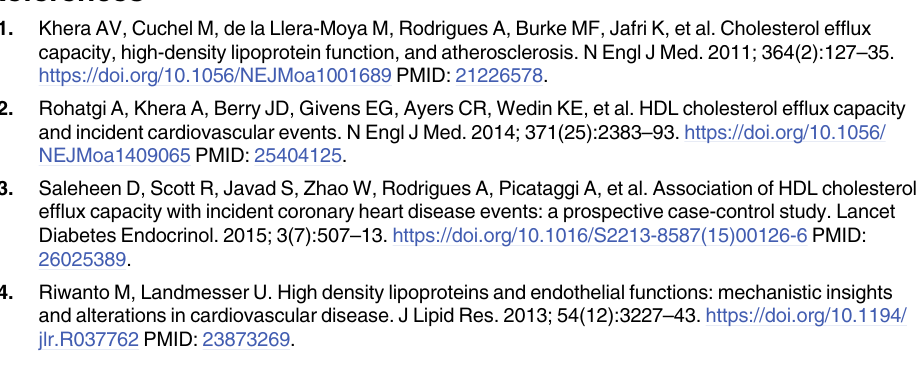
S1 Table. List of proteins and corresponding peptides included in targeted proteomics